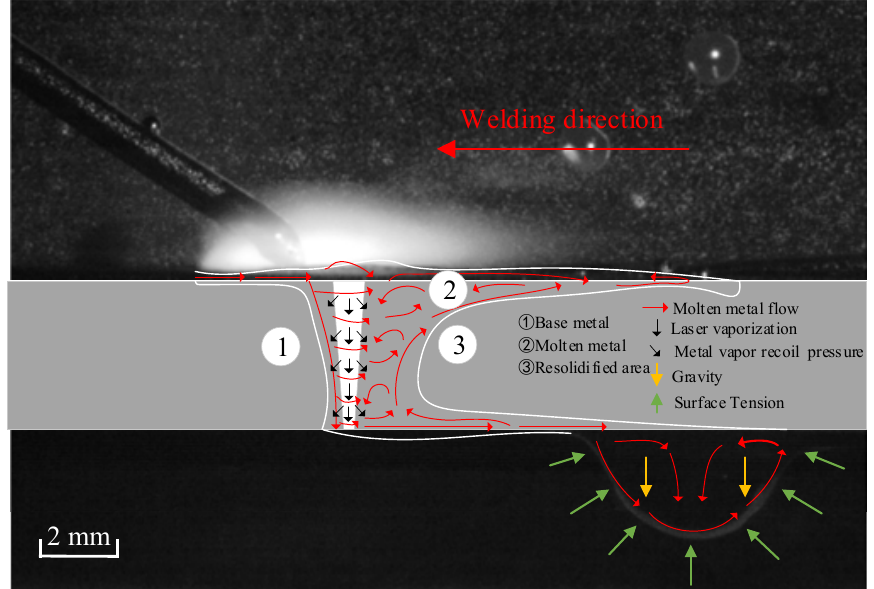
Figure 9. Schematic diagram of molten metal flow during root humping formation.